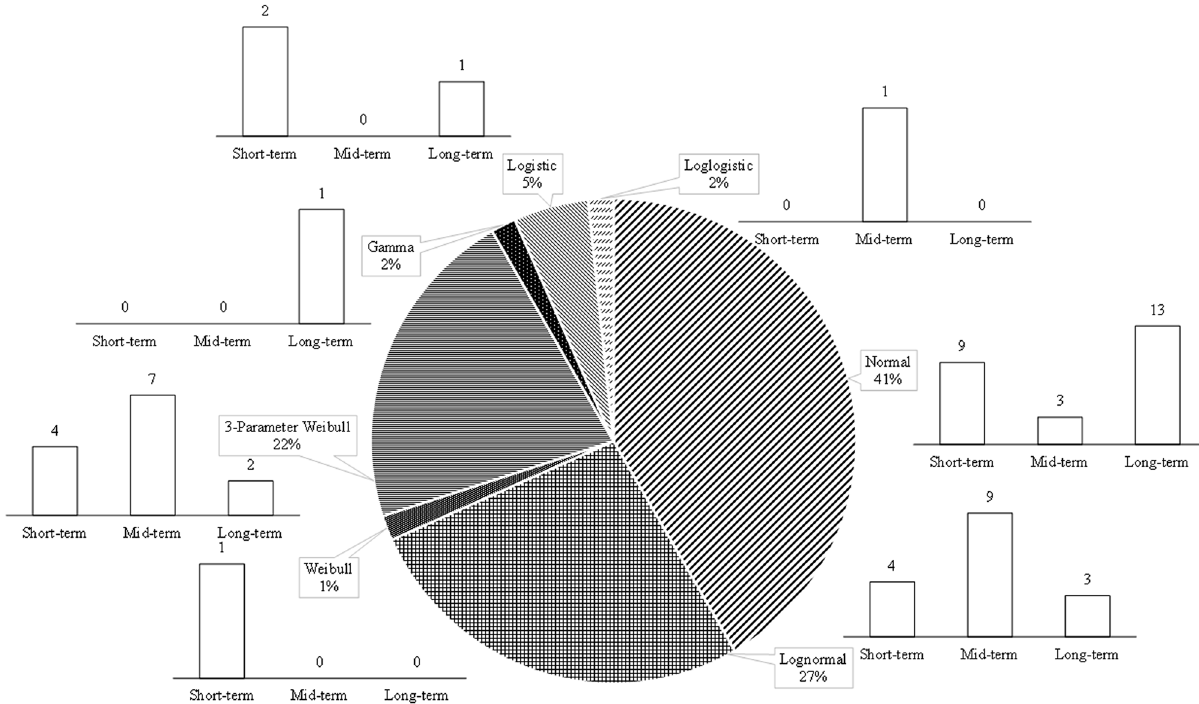
Figure 8. The frequency with which each theoretical distribution was found suitable to describe the stochastic distribution of the μ parameter.